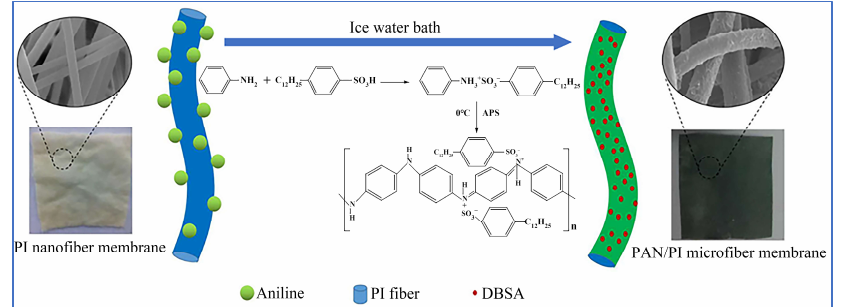
Figure 4. Schematic of preparation process of the PANI/PI microfiber membranes via in situ polymerization [107].